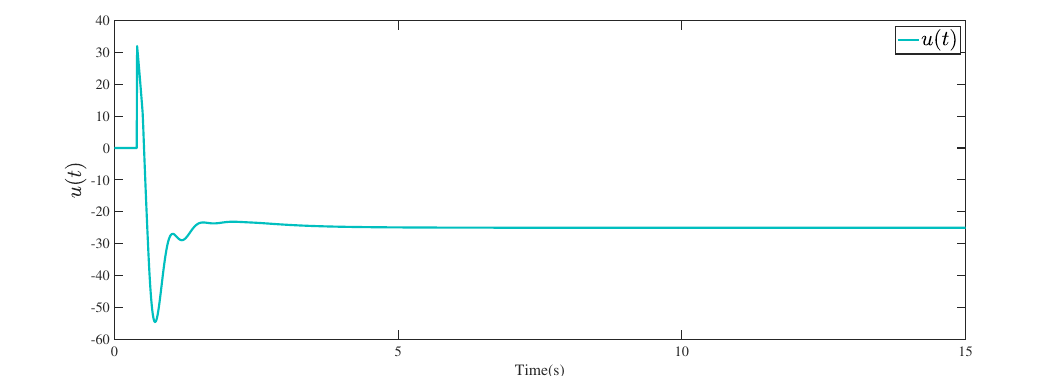
Figure 3. Trajectories of the states of system (27).